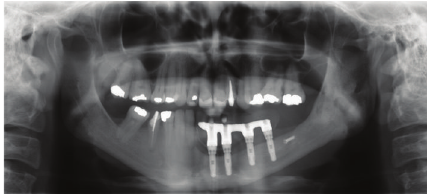
Figure 11: Panoramic radiographic 6 years after tumor